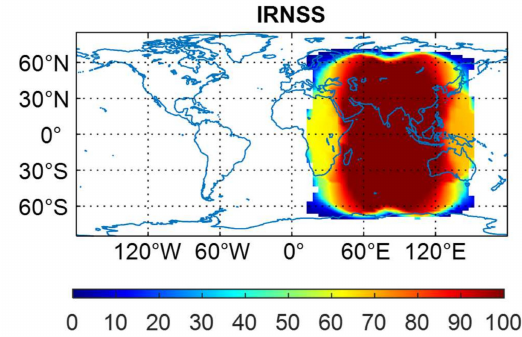
Figure 5. Service rate of IRNSS-only case (unit: %).